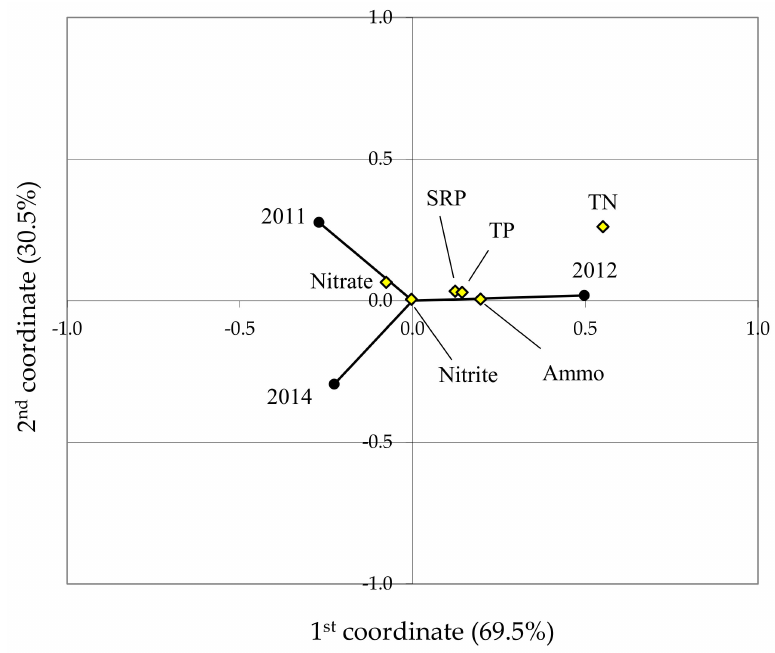
Figure 12. Position of selected years determined by trophic parameters in the space of the first two canonical varieties and spacing of these parameters in the dual space (trait coordinates rescaled and divided by 20).